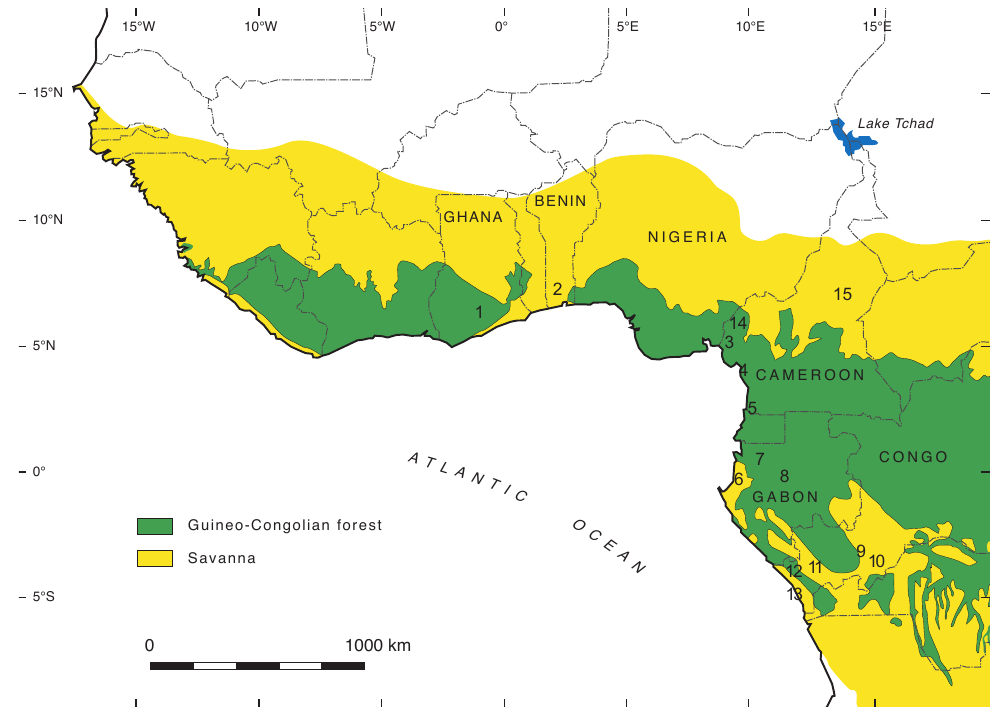
Fig. 1. Location of fossil pollen sites in west and central atlantic Africa 1: Bosumtwi. 2: S´el´e. 3: Barombi Mbo/Mboandong. 4: Ossa. 5: Nyabessan. 6: Maridor. 7: Ngu`ene. 8: Kamal´et´e. 9: Bilanko. 10: Ngamakala. 11: Sinnda. 12: Kitina. 13: Coraf/Songolo. 14: Bambili. 15: Mbalang (map adapted from Ngomanda et al.,